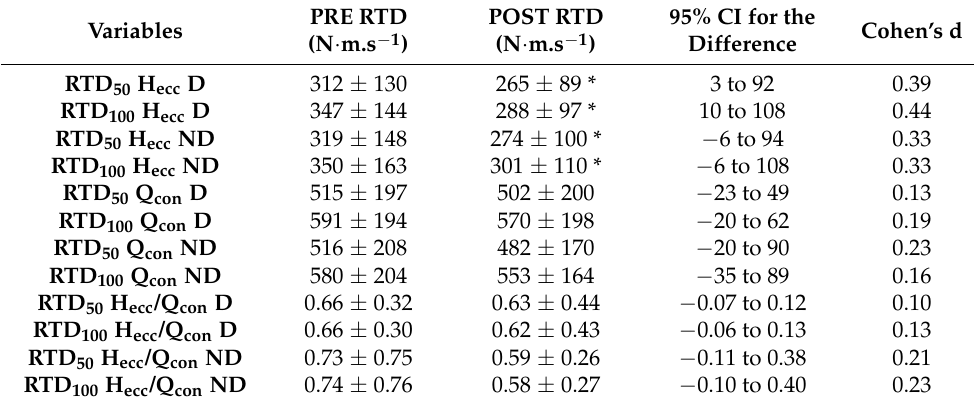
Table 4. Rate of torque development in the first 50ms (RTD 50 ) and100 ms (RTD 100 ) before (PRE) and after (POST) the simulated football exercise (BEAST 90 ). PRE RTD POST Variables (N · m.s − 1 )